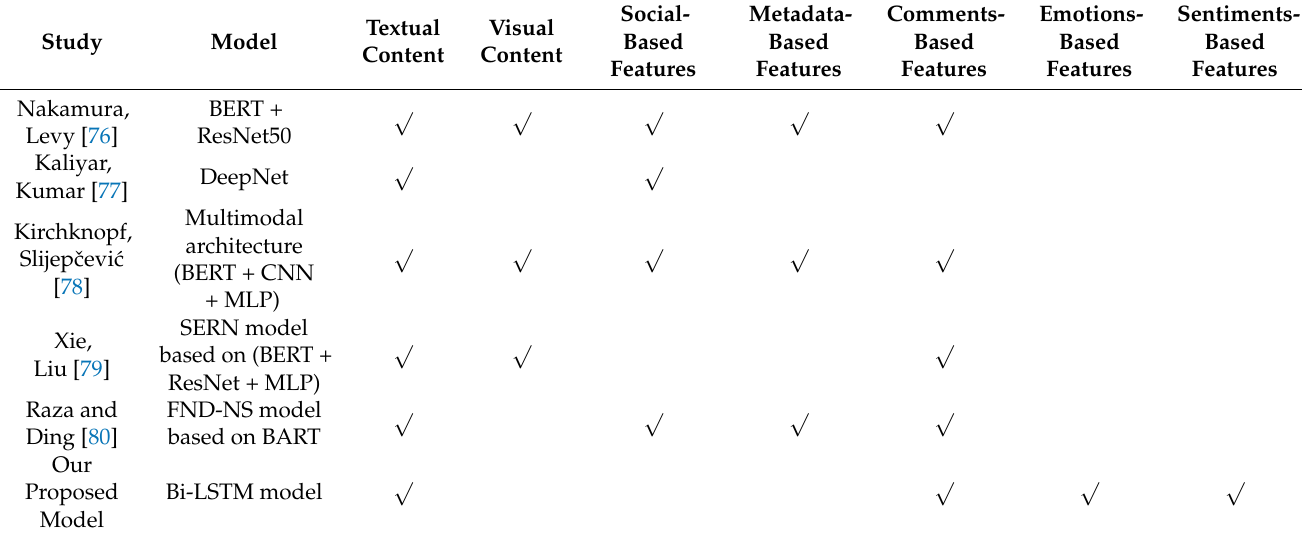
Figure 15. The training and validation loss of the proposed Bi-LSTM model. The following Table 6 shows the features used by the proposed models in detecting fake news in related works that used the same standard dataset as compared to our model. Table 6. The features used in detection models, (A checkmark indicates that this feature is selected).